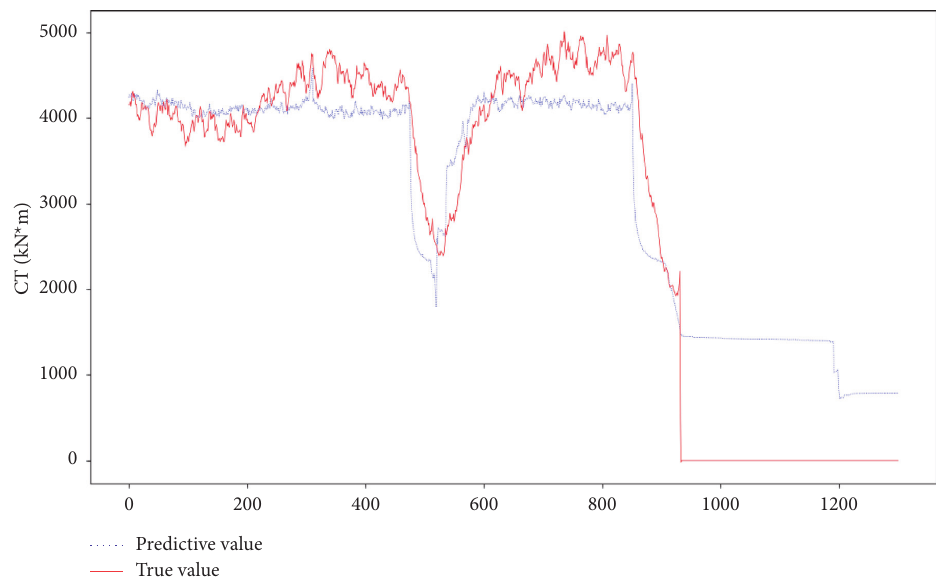
Figure 9: Effect of predicting cutterhead torque by using the linear regression model on the nonsegmented dataset. Table 3: Comparison of scores with different models.